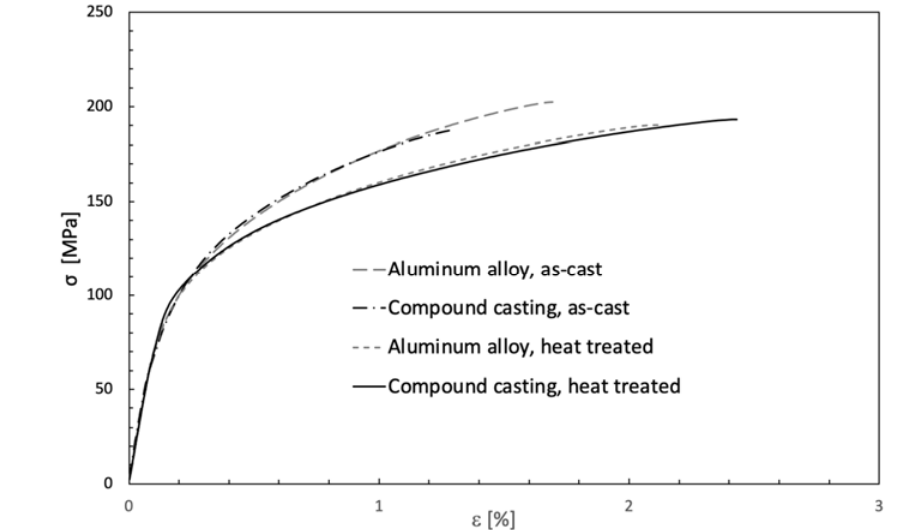
Figure 8: Stress-strain curves of the compound castings and Al alloy in different conditions.